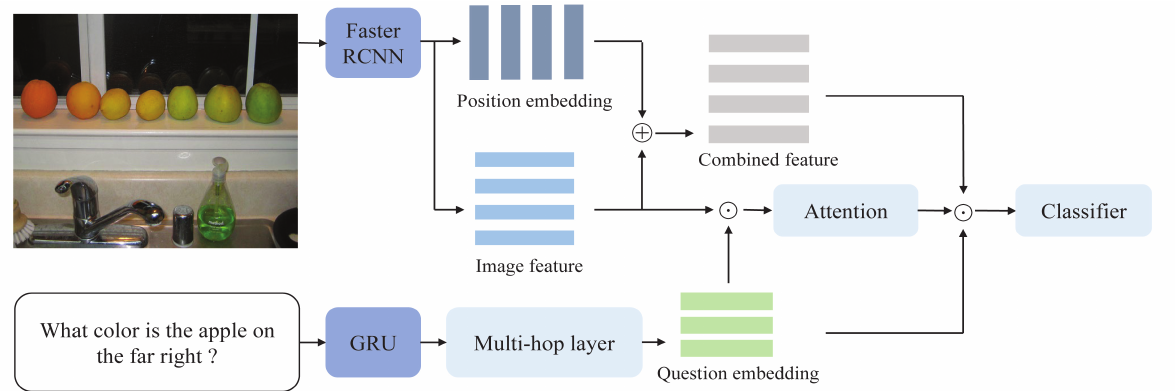
Figure 1. Overview of the proposed VQA model. ⊕ denotes concatenation operation and (cid:12) denotes matrix